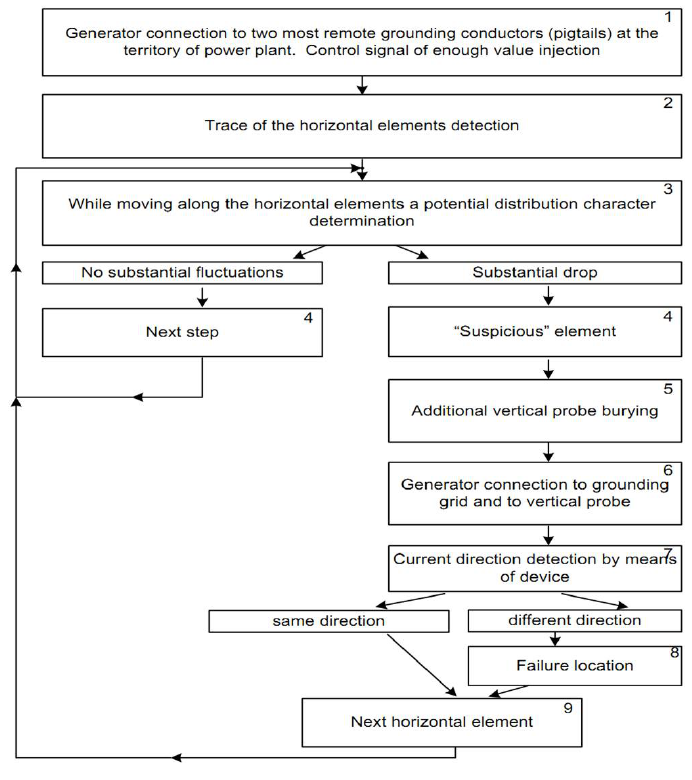
Figure 6. Algorithm of Grounding Investigation.